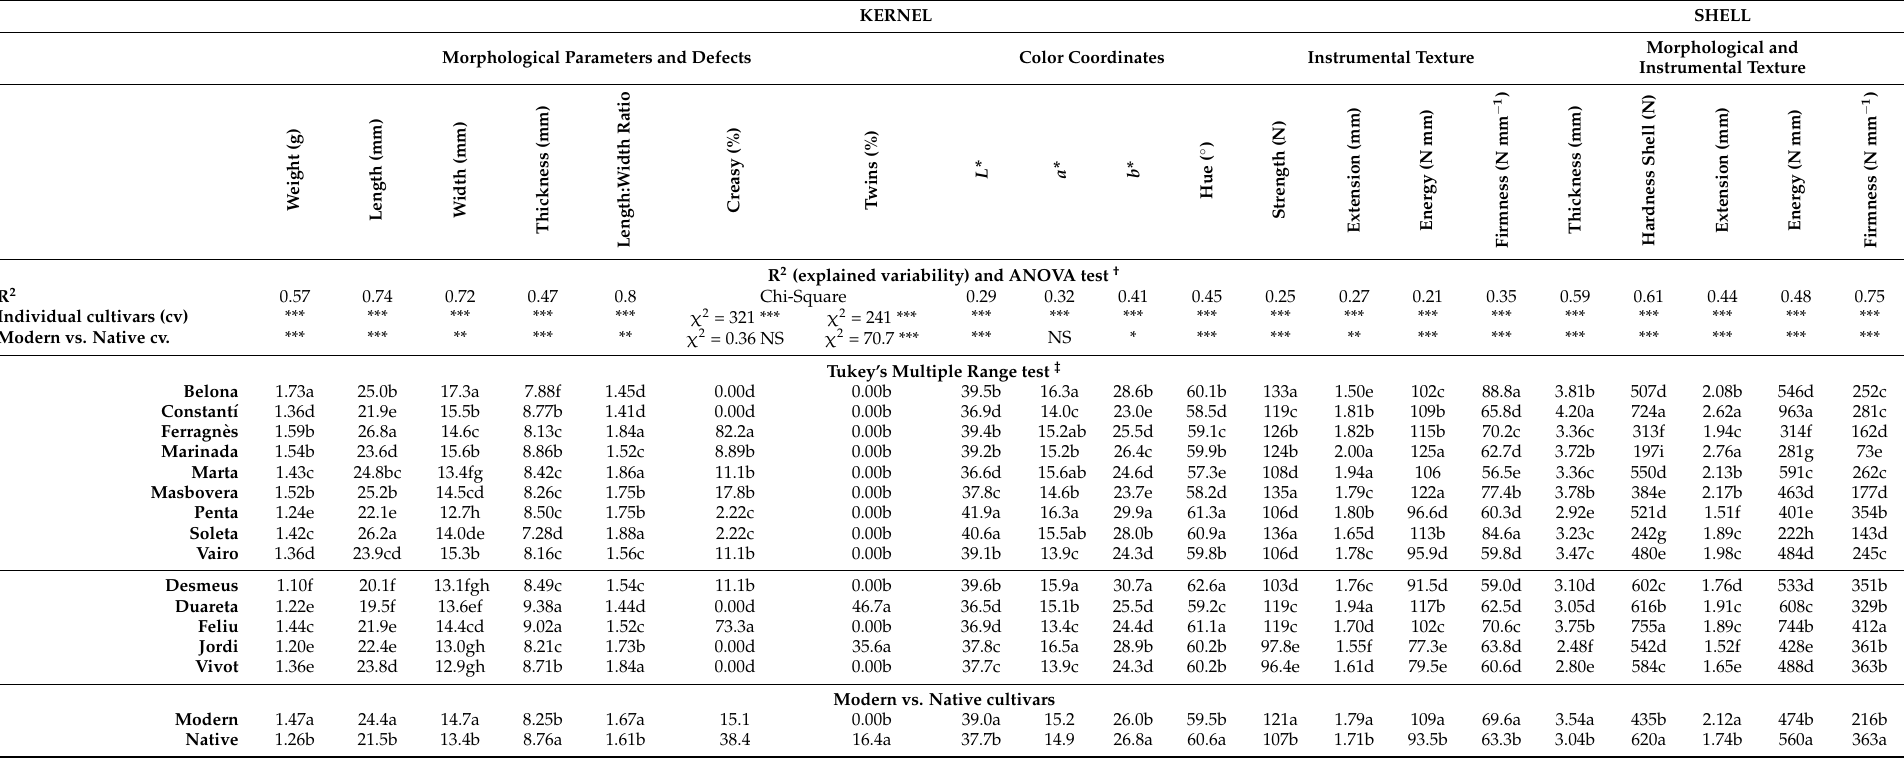
Table 1. Morphology, instrumental color, and texture of 14 almond cultivars (9 modern and 5 native cultivars). KERNEL SHELL Morphological Parameters and Defects Color Coordinates Instrumental Texture Morphological and Instrumental